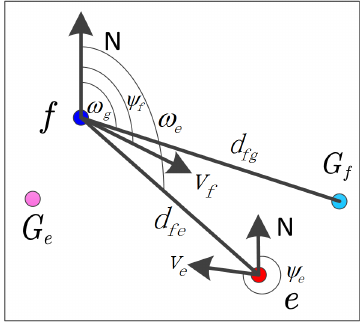
Figure 3. The denotations for the state